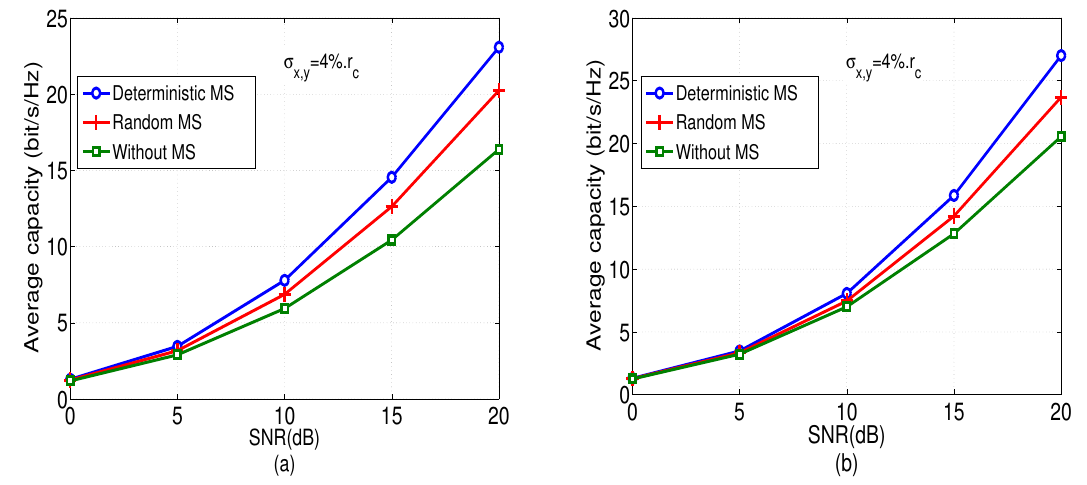
Figure 5. Average capacities vs. SNR for a misalignment std σ x , y = 4% r c . ( a ) 6-mode fiber; ( b ) 10-mode fiber.